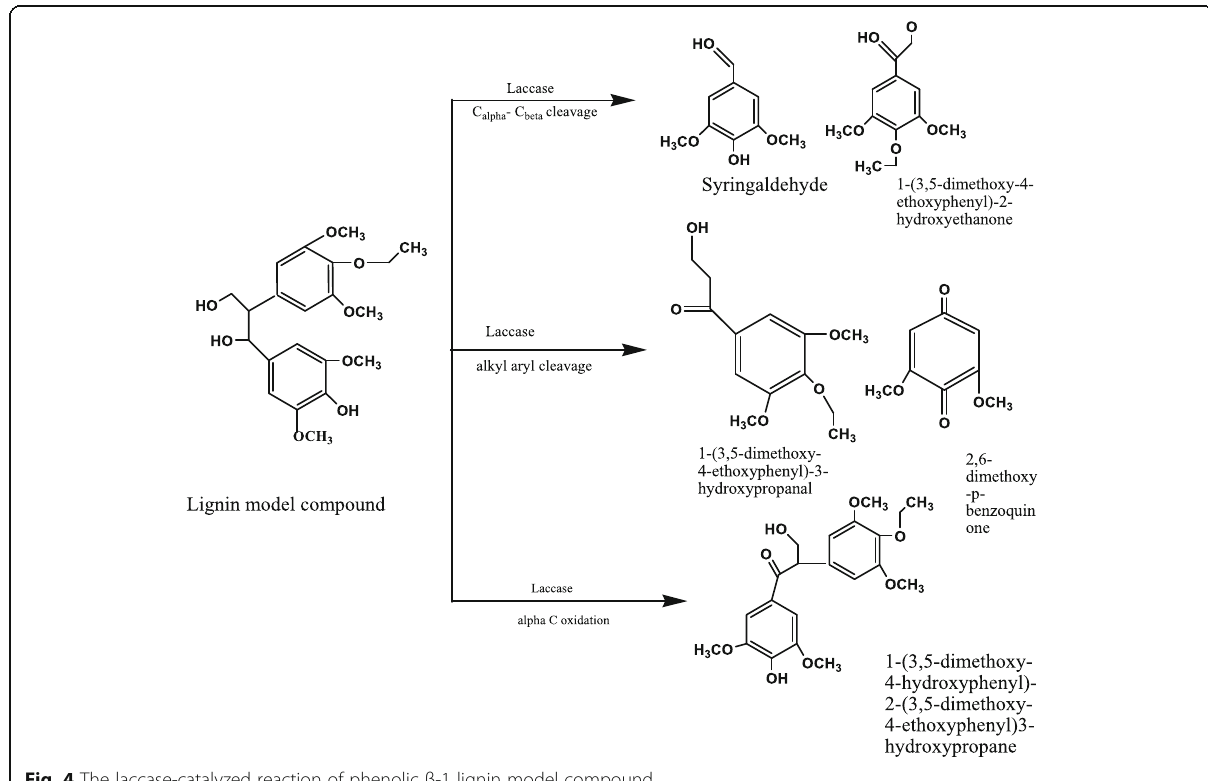
Fig. 4 The laccase-catalyzed reaction of phenolic β -1 lignin model